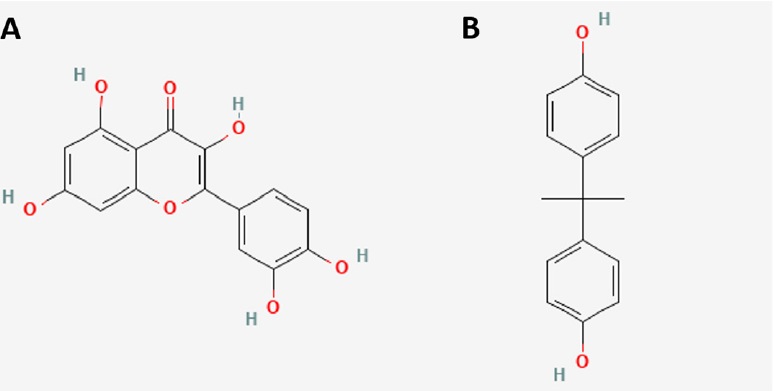
Figure 1. Chemical structures of Q ( A ) and BPA ( B ). The images were downloaded from PubChem, Q = CID: 5,280,343 and BPA = CID: 6623. Gastrointestinal digestion and in vitro fermentation of Q in the colon lead to the formation of several metabolite derivatives. The compounds quantified in the fermented extract of quercetin (FEQ) by HPLC were Q and 3,4-dihydroxyphenylacetic acid (DOPAC) (Table